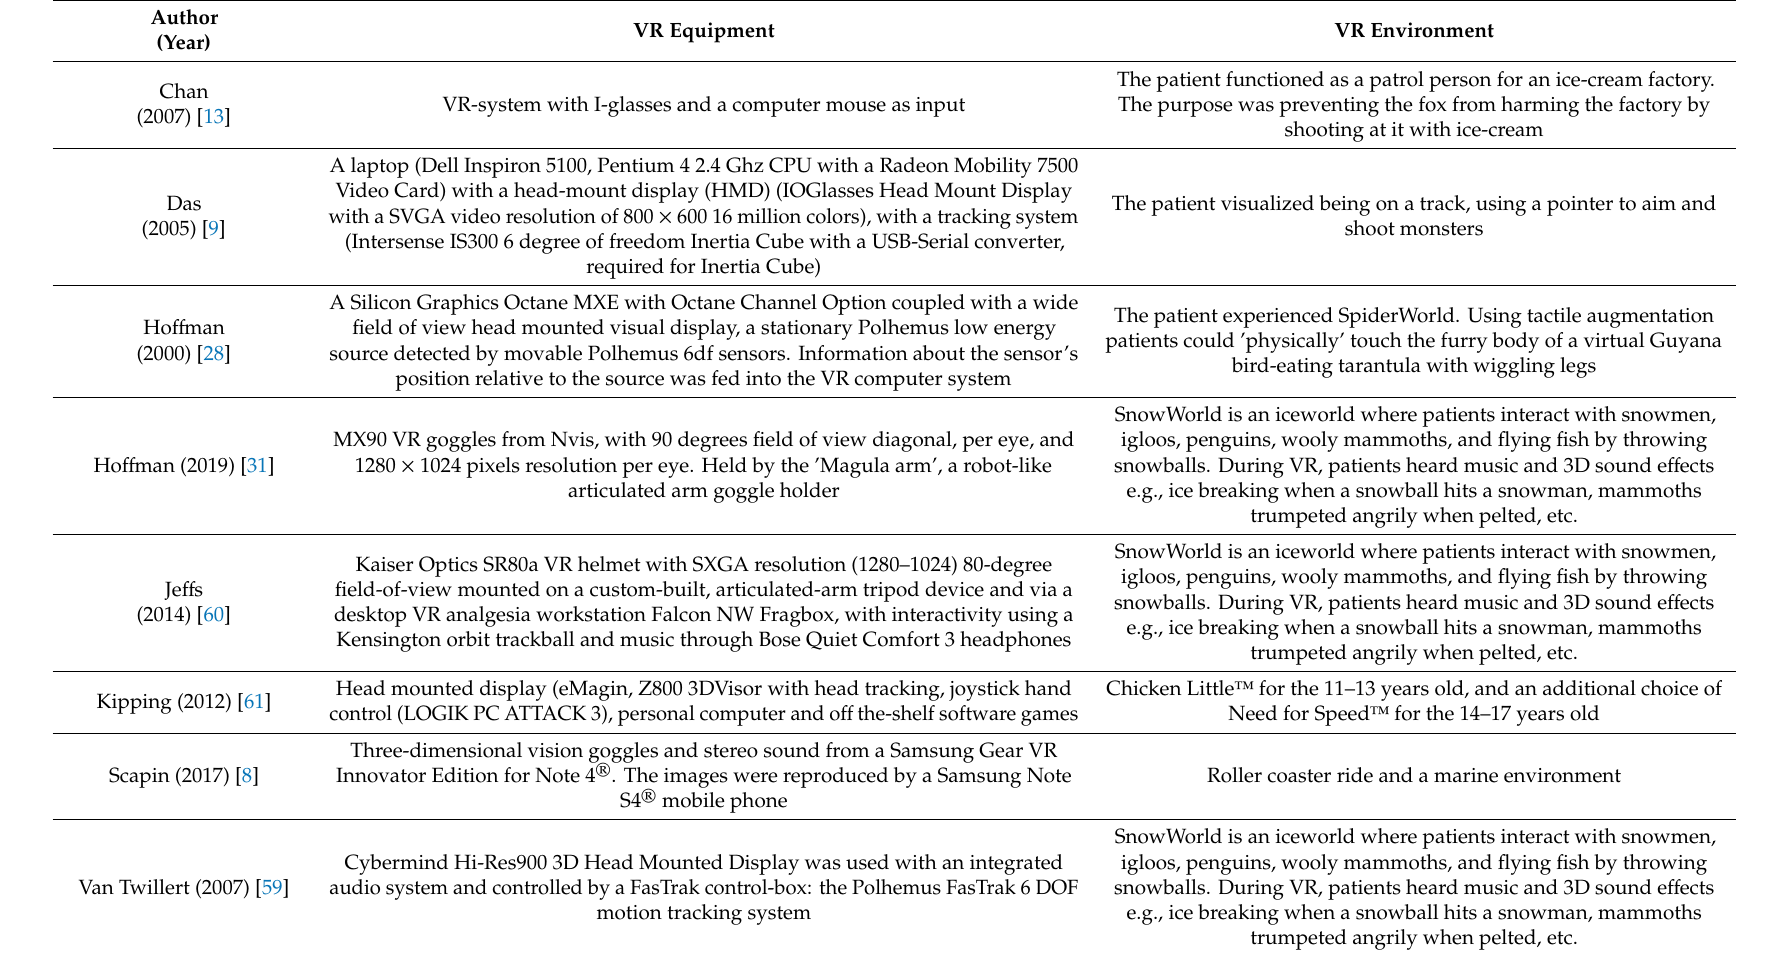
Table A2. Summary of findings for the included studies